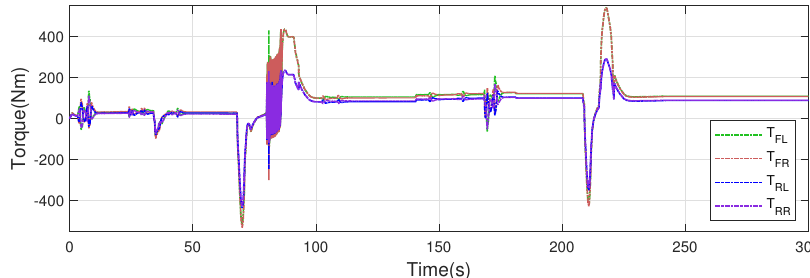
Figure 12. Multi-objective optimal allocation for EVs.